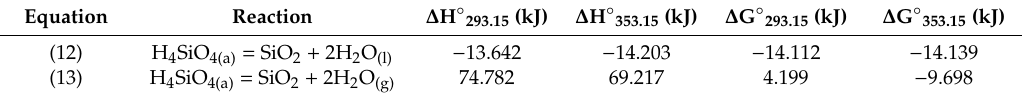
Table 5. Thermodynamic data of reactions in which SiO 2 precipitates from H 4 SiO 4 .